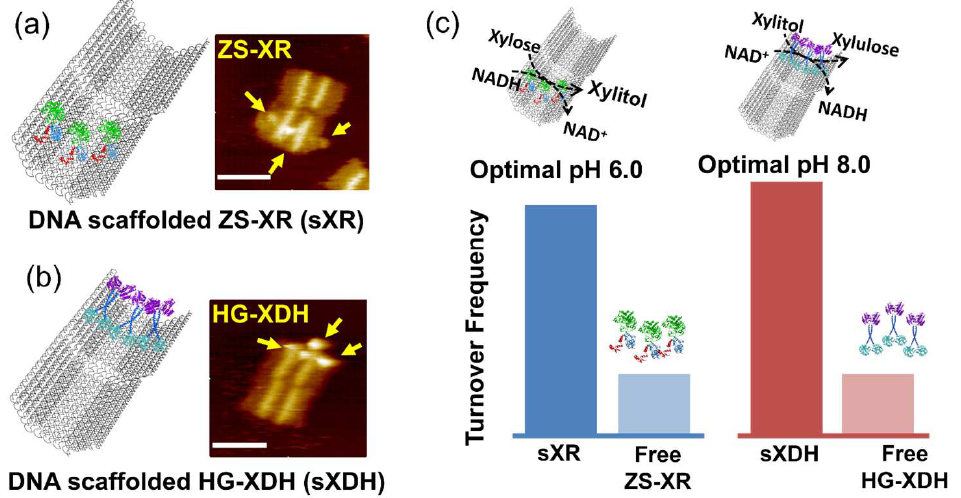
Figure 7. Xylose reductase (XR) and xylitol dehydrogenase (XDH) with different optimal reaction pH were individually assembled on the DNA scaffold [78]. ( a ) ZS-XR (modular adaptor ZF-SNAP fused XR) assembled on the DNA scaffold (sXR) and its AFM image, scale bar: 100 nm. The arrows in yellow indicated enzymes on the DNA scaffold. ( b ) HG-XDH (modular adaptor Halo-GCN4 fused XDH) assembled on the DNA scaffold (sXDH) and its AFM image, scale bar: 100 nm. ( c ) Turnover frequency of the enzyme reactions of free or scaffolded enzymes. Reprinted with permission from Ref. [78]. Copyright 2021 Royal Society of Chemistry.